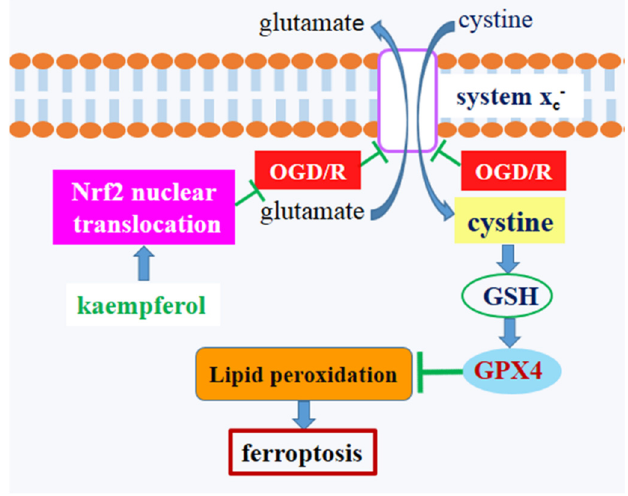
Figure 7. Schematic diagram showing the protective mechanism of kaempferol against OGD/R-induced ferroptosis in neurons.